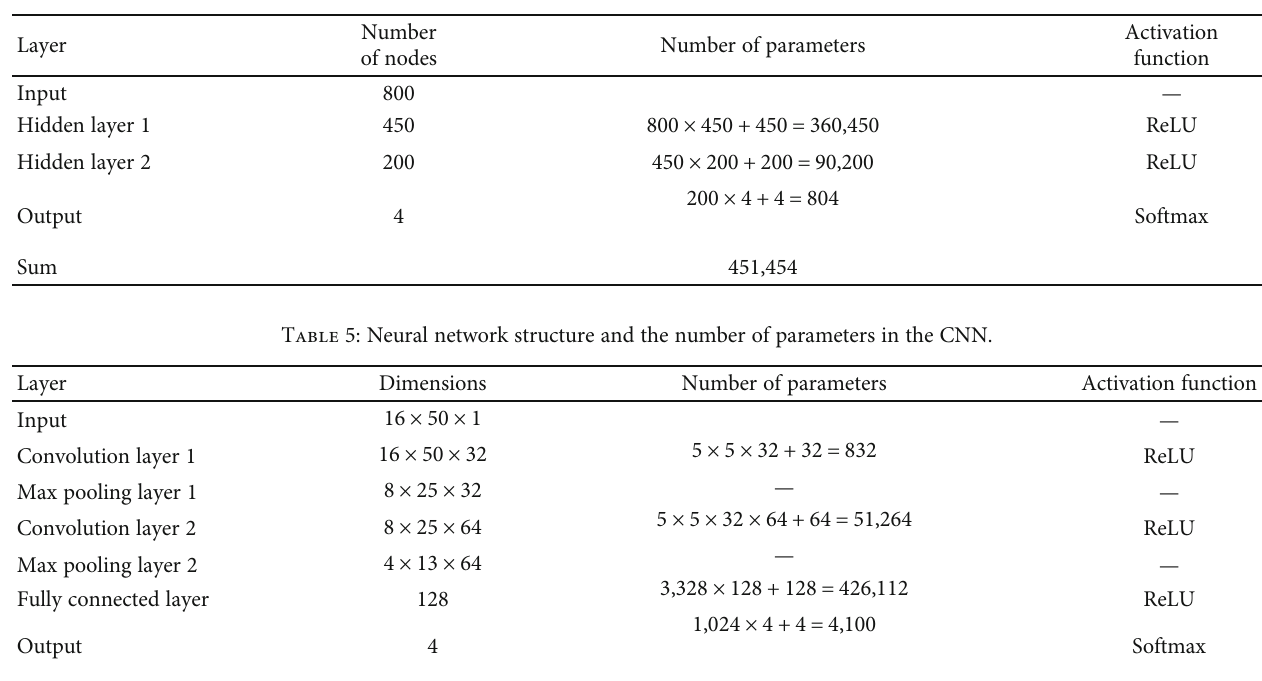
Figure 9: The matrix of the 800 production data for the input layer in the CNN: (a) arrangement of the production data and (b) example of an input image. Table 4: Neural network structure and the number of parameters in the ANN.